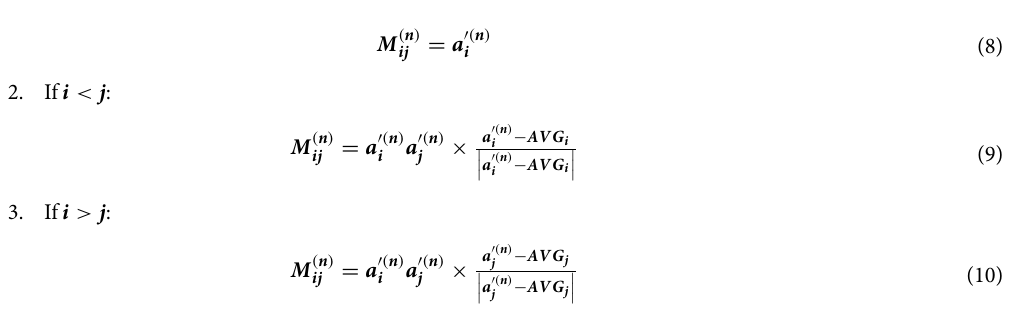
Figure 3. A convolutional neural network